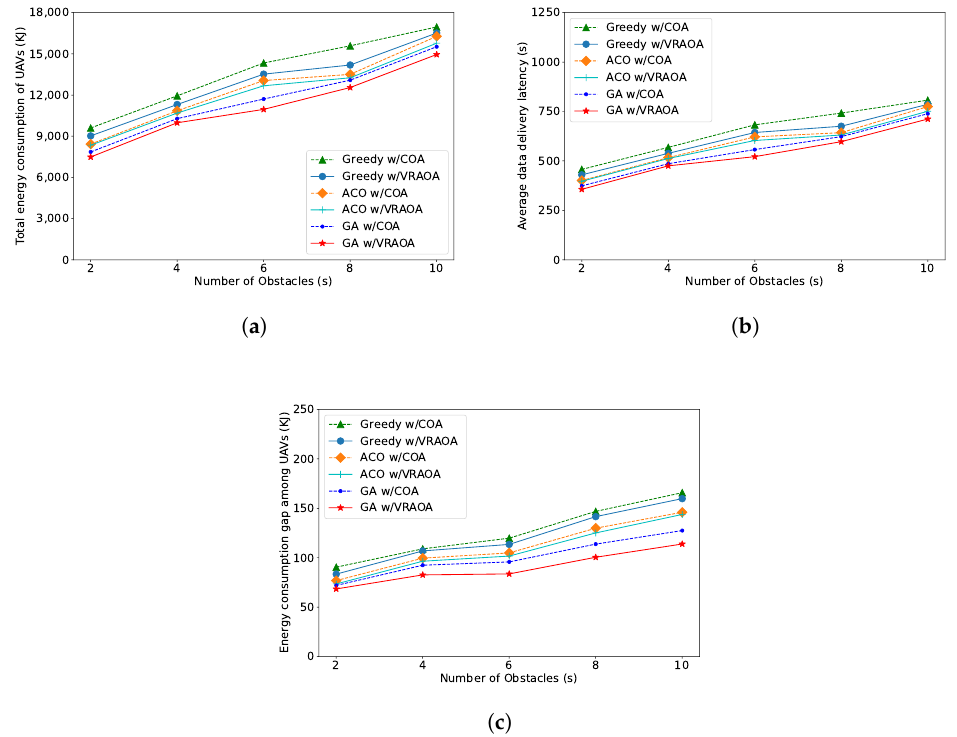
Figure 10. Effects of the number of obstacles: ( a ) effect on total energy consumption of UAVs, ( b ) effect on average data delivery latency, and ( c ) effect on energy consumption gap (standard deviation) among